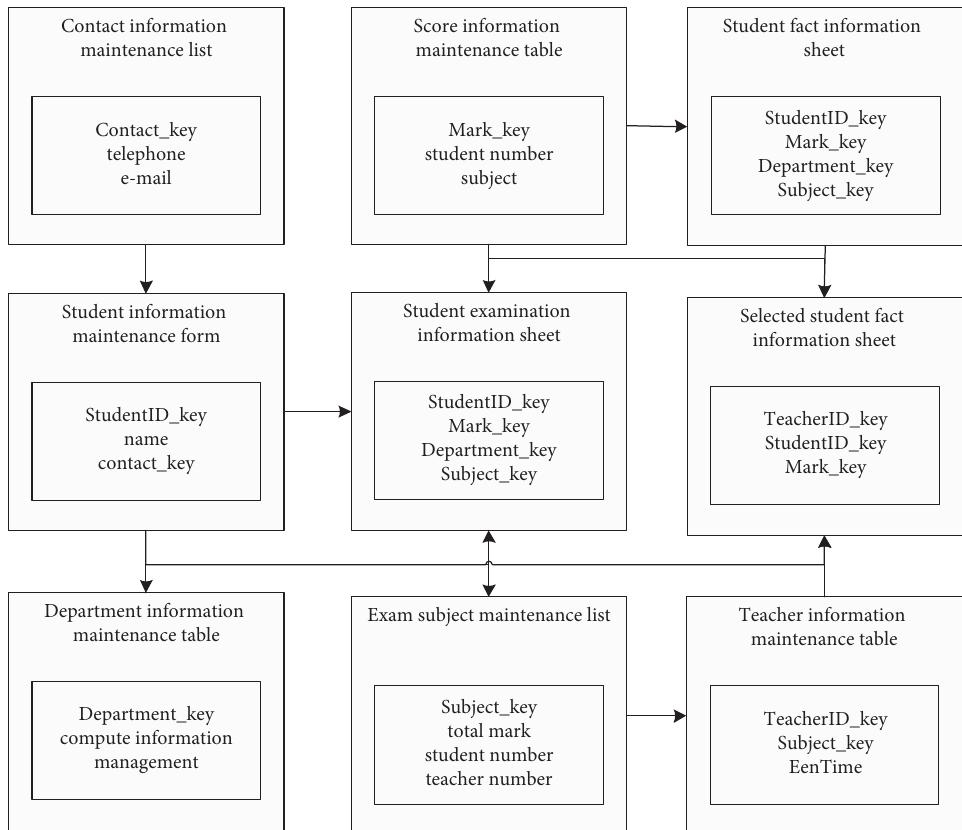
Figure 1: Massive educational examination big data